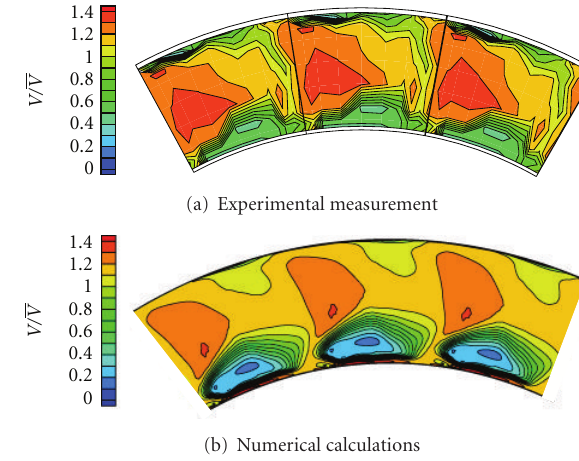
Figure 7: Mid-span wake downstream of the blade.